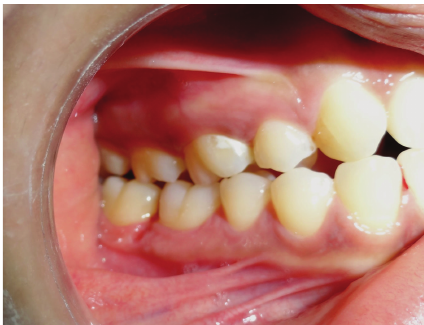
Figure 5: Periapical radiograph showing mild crestal bone loss between first and second molars.